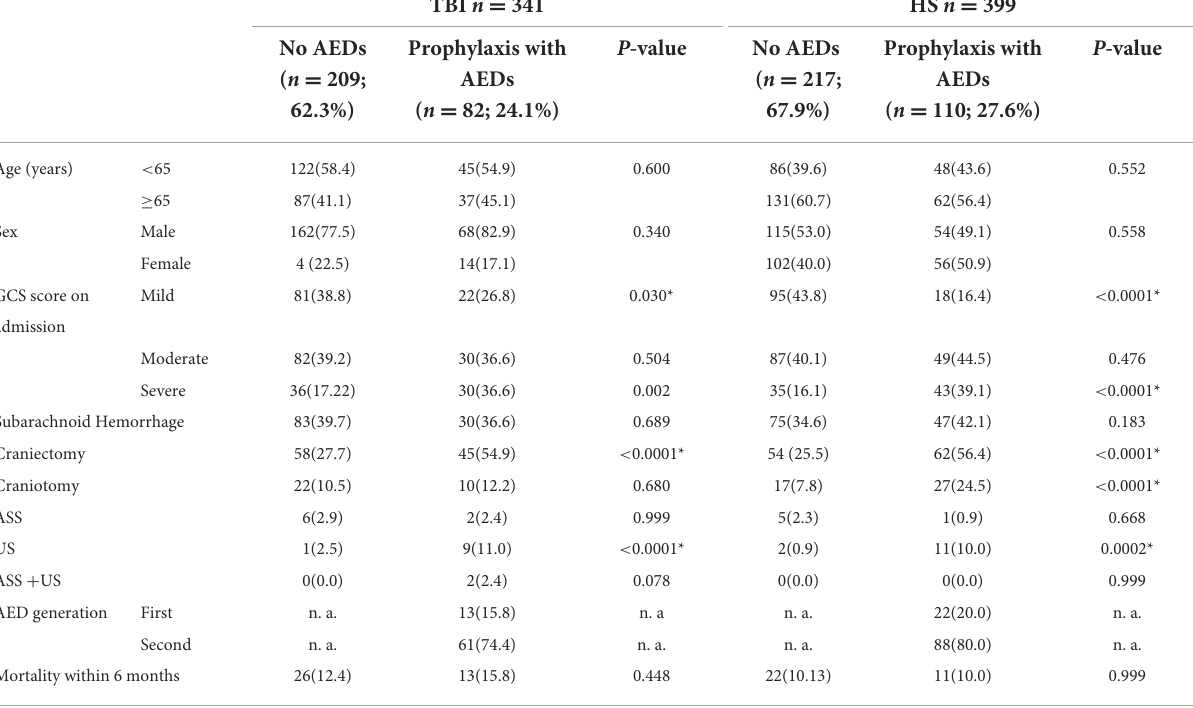
TABLE 2 Clinical and demographic characteristics of patients with acquired brain injury according to type of injury and the use of primary prophylaxis with AEDs.